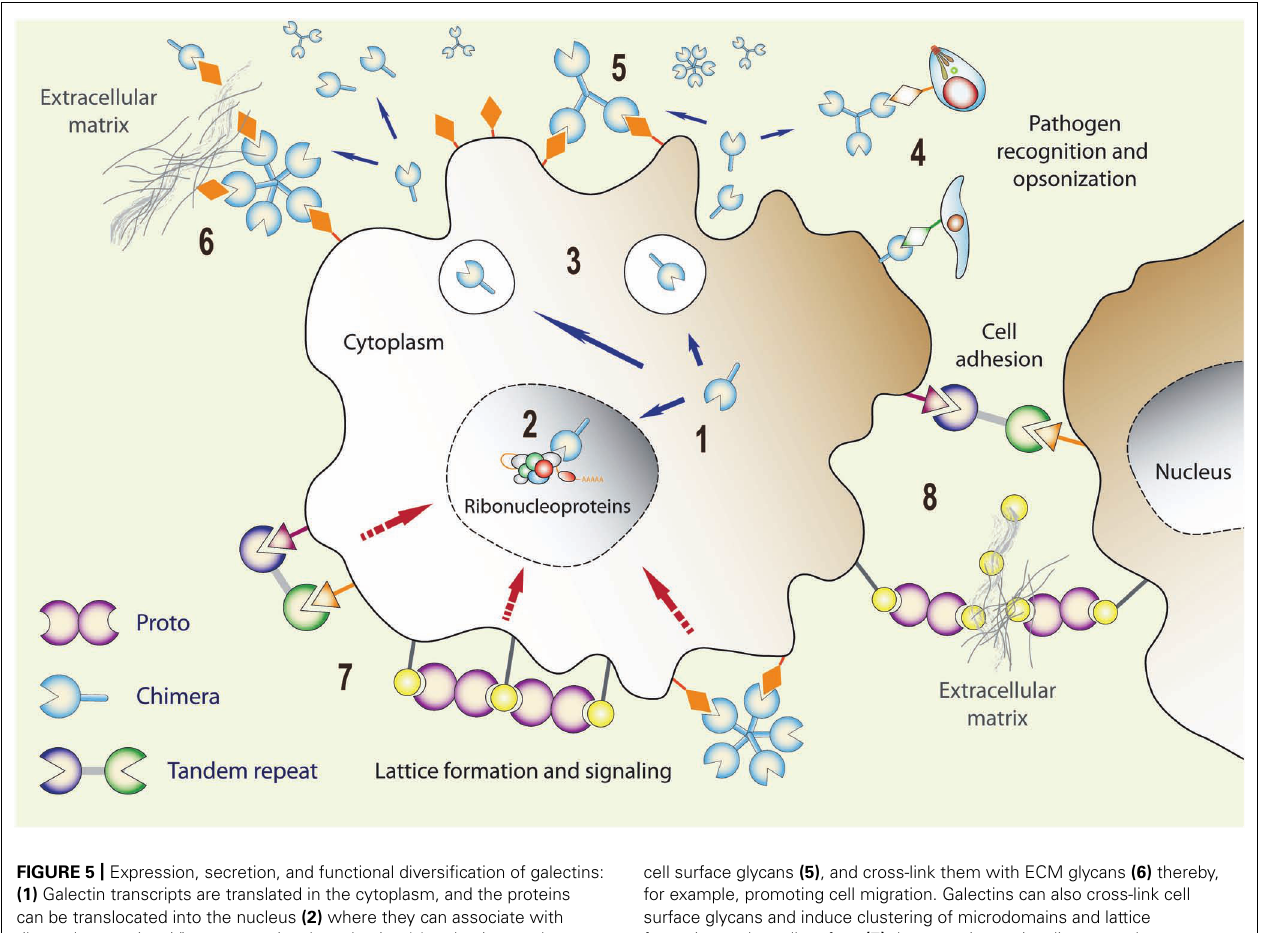
FIGURE 5 | Expression, secretion, and functional diversification of galectins: (1) Galectin transcripts are translated in the cytoplasm, and the proteins can be translocated into the nucleus (2) where they can associate with ribonucleoproteins. Via unconventional mechanism(s), galectins can be secreted to the extracellular space (3) where they can function as pattern recognition receptors for microbial glycans (4) , bind to the host